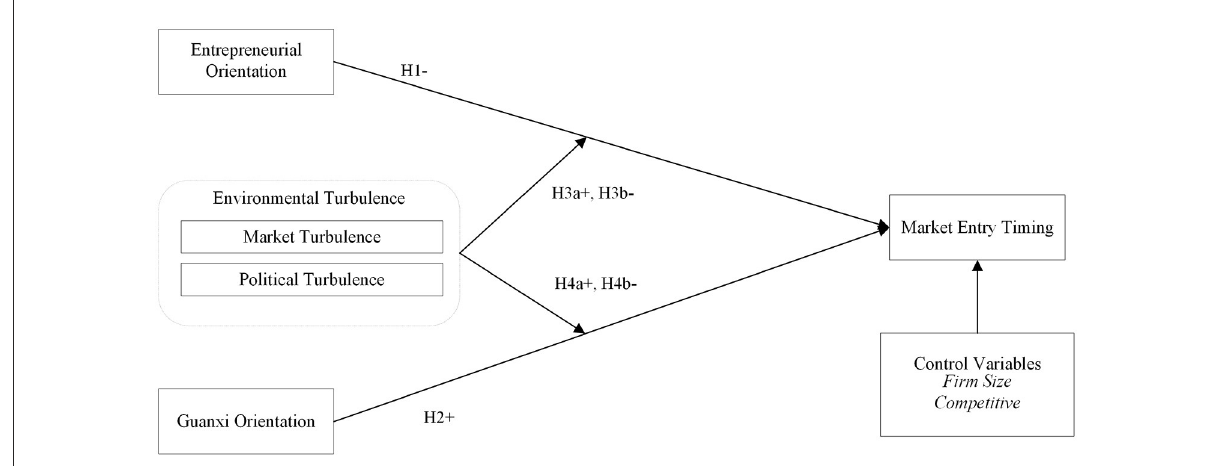
FIGURE1 Conceptual model and hypothesized